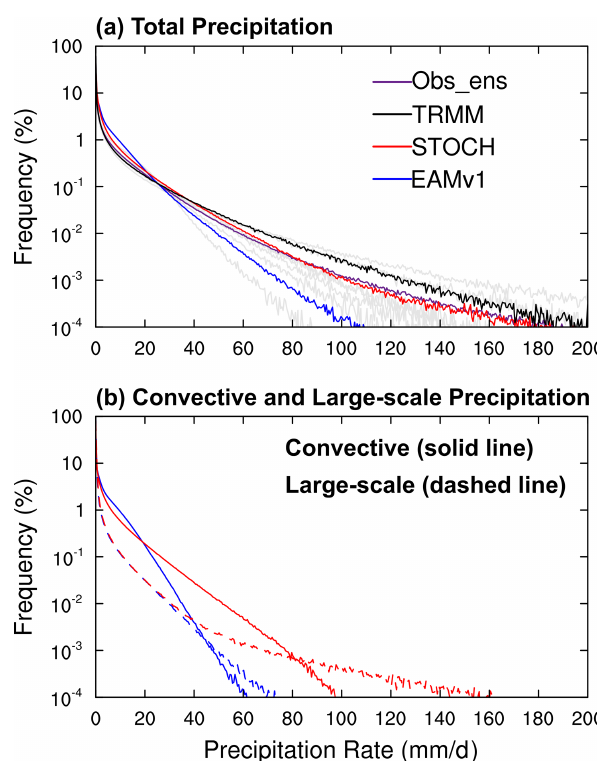
Figure 3. Frequency distributions of (a) total (solid line), (b) con- vective (solid line) and large-scale (dashed line) precipitation inten- sity over the tropics (20 ◦ S, 20 ◦ N) for EAMv1 (blue) and STOCH (red), respectively. For total precipitation, the TRMM observations (black) and the ensemble mean of multiple observations (Obs_ens, purple), with each observation represented by a gray line, are in- cluded for